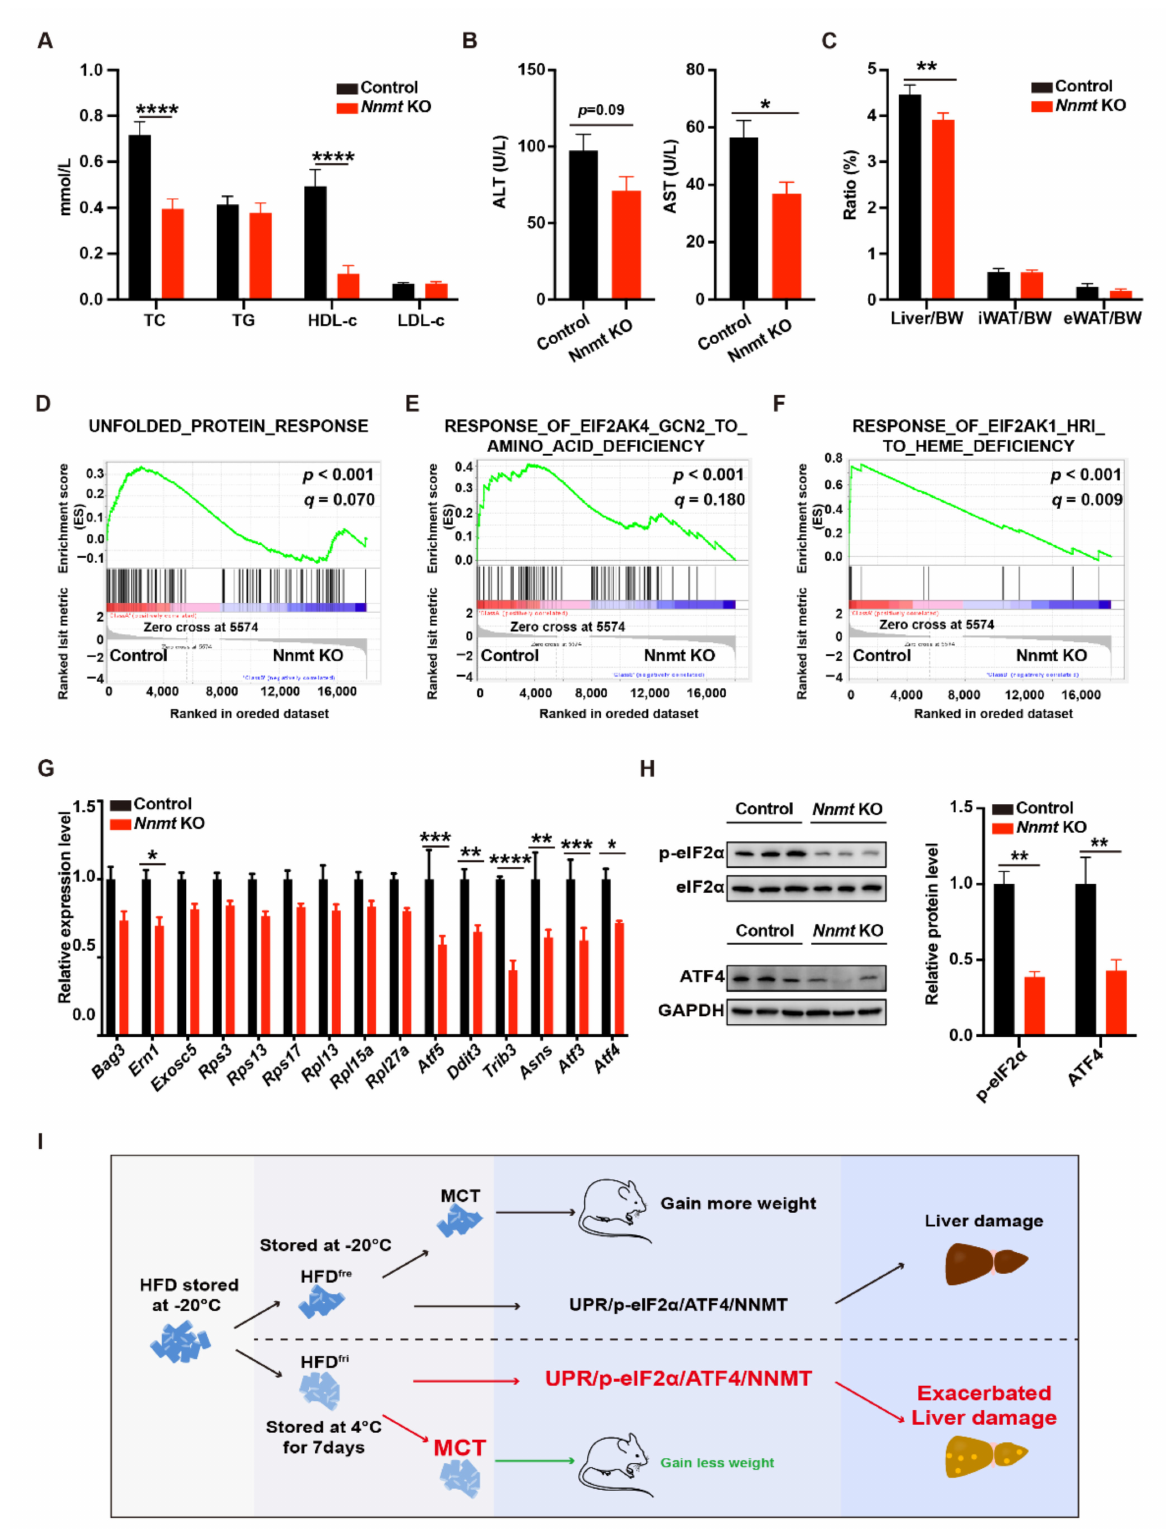
Figure 5. Nicotinamide N-methyl transferase knockout (NNMT KO) protected liver from methionine- and choline-deficient (MCD) diet-induced damages. ( A , B ) Analysis of the serum lipid profile (( A ) p < 0.0001 from two-way ANOVA) and the serum concentration of alanine aminotransami- nase (ALT) and aspartate aminotransferase (AST) ( B ) (control, n = 6; Nicotinamide N-methyl transferase knockout (NNMT KO), n = 7); ( C ) the proportion of liver, inguinal white adipose tissue (iWAT),